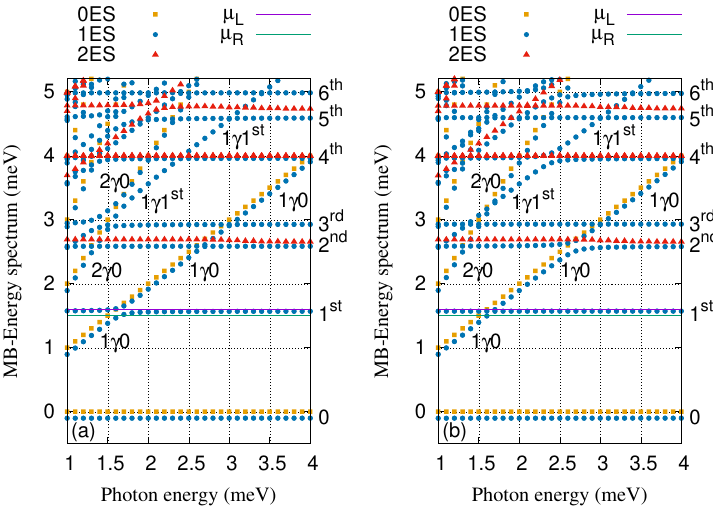
Figure 2. Many-Body energy spectra of the cavity-QD system versus the photon energy for x - ( a ) and y -polarized ( b ) photon field, where brown squares refer to zero-electron states (0ES), blue circles display one-electron states (1ES), and red triangles are two-electron states (2ES). The chemical potential of the left and the right leads are µ L = 1.65 meV (purple line) and µ R = 1.55 meV (green line), respectively. 0 is the one-electron ground-state energy, 1 γ 0 and 2 γ 0 demonstrates the one- and two-photon replica of the 0, and 1st, 2nd, 3rd, 4th, 5th, 6th indicate the one-electron first-, second-, third-, fourth-, fifth- and sixth-excited state, respectively. The 1 γ 1st indicates the one-photon replica state of the 1st. The photon number initially in the reservoir n R = 1, g γ = 0.1 meV, and κ = 10 − 5 meV. The magnetic field is B = 0.1 T, eV g = 0.651 meV, T L,R = 0.5 K and ¯ h Ω 0 = 2.0